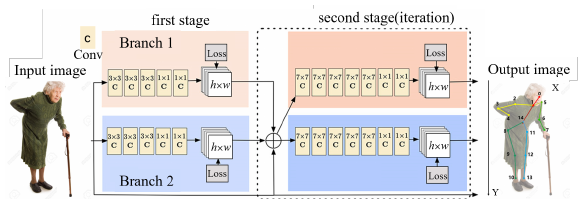
Fig. 2. Detection model of human skeleton and key points based on